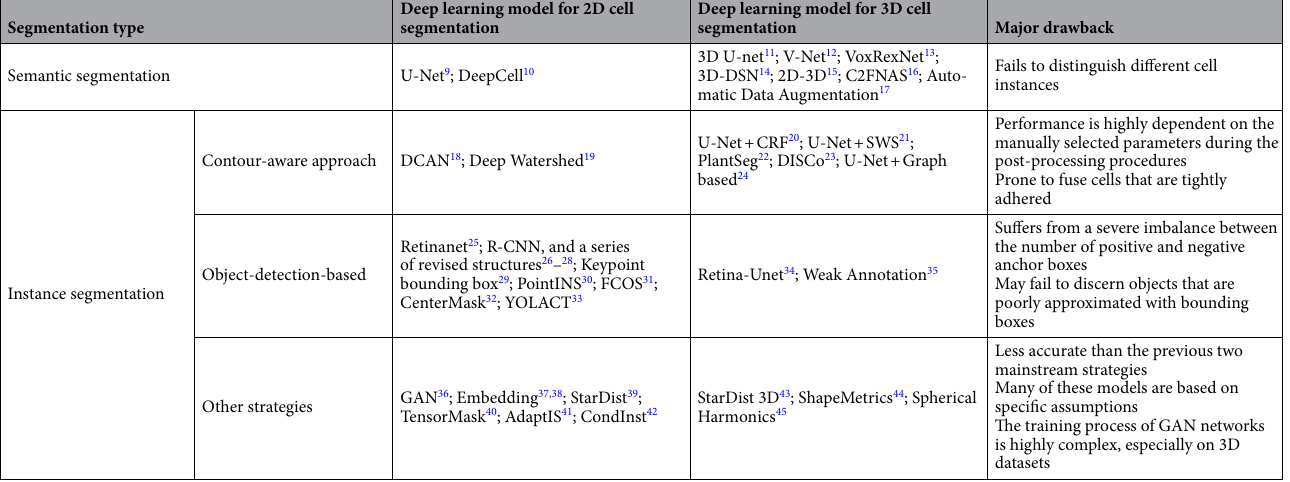
Table 1. An overview of the existing deep learning models for 2D/3D cell